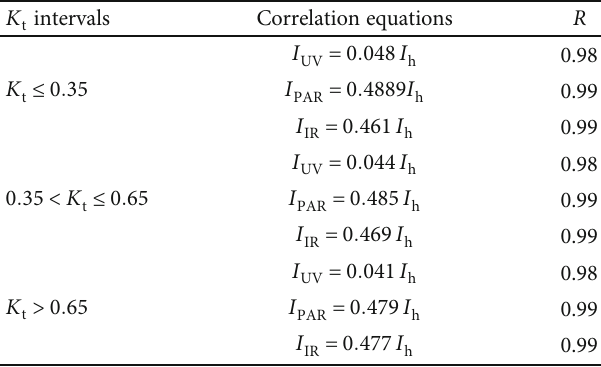
Table 7: The equations for predicting the values of I I IR .